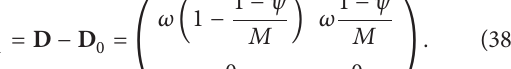
Figure 3: Average response time 𝜎 of data packets versus sleep cycle 𝑇